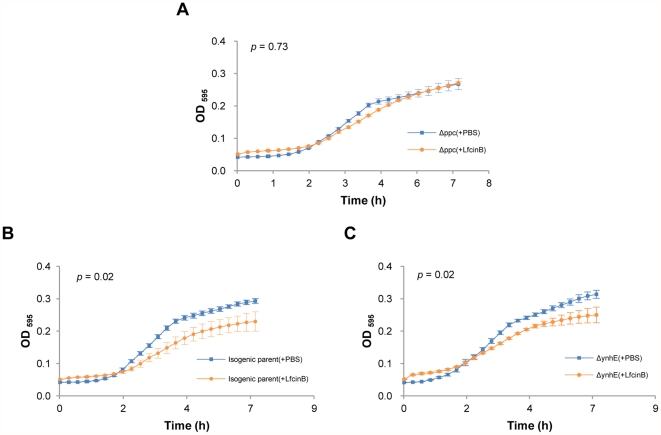
Comparison of the growth inhibition between knockout strains and the isogenic parent strain using knockout assays.We compared the effects of LfcinB on the growth of 16 E. coli knockout strains and the isogenic parent strain to examine which gene can escape from the effects of LfcinB. We used PBS (LfcinB dissolving buffer) as the negative control. A. Δppc with or without LfcinB have similar growth curves (p>0.05). B. The isogenic parent strain has a significant difference (p<0.05) between treatment with or without LfcinB. C. ΔynhE, representing the other 15 knockout strains (p<0.05), is similar to the isogenic parent strain. These results indicate that Δppc avoided the LfcinB attack.